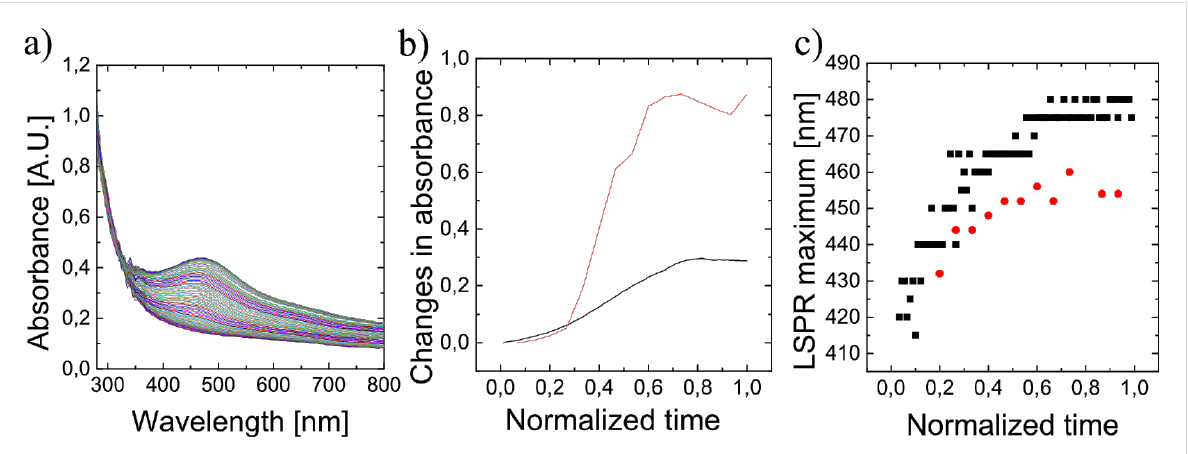
Figure 3: a) Time evolvement of UV–vis spectra of ≈ 1:50 pineapple extract/AgNO 3 solution between 0 and 180 minutes after mixing in darkness, for comparison see Figure 1c that displays the same process in the presence of light. b) Peak growth taken from Figure 1c and Figure 3a as a function of normalized time. c) Peak position taken from Figure 1c and Figure 3a as a function of normalized time. Red and black data in Figure 3b,c are with and without light, respectively.